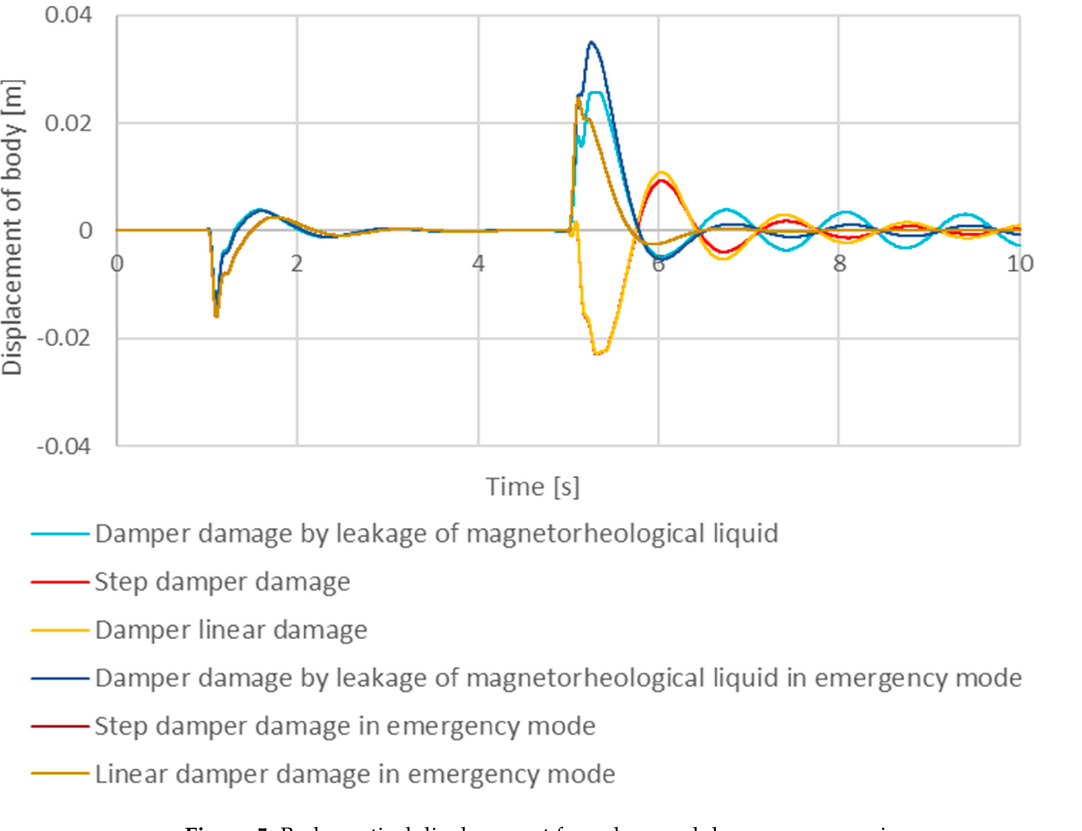
Figure 5. Body vertical displacement for a damaged damper—comparison.